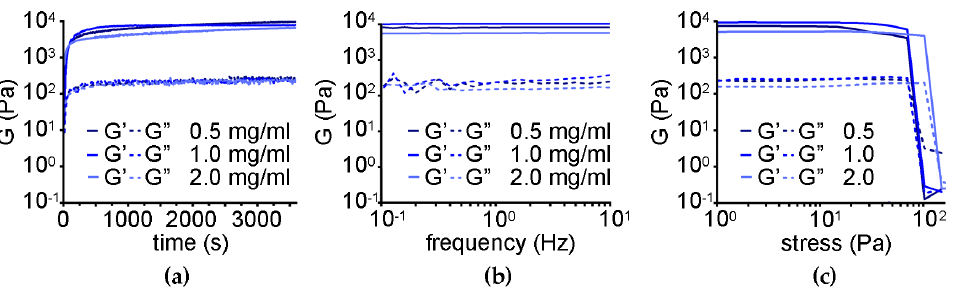
Figure 9. Oscillatory rheology of the nanocomposite supramolecular hydrogels obtained through the covalent approach. ( a ) Time sweeps. ( b ) Frequency sweeps. ( c ) Stress sweeps.